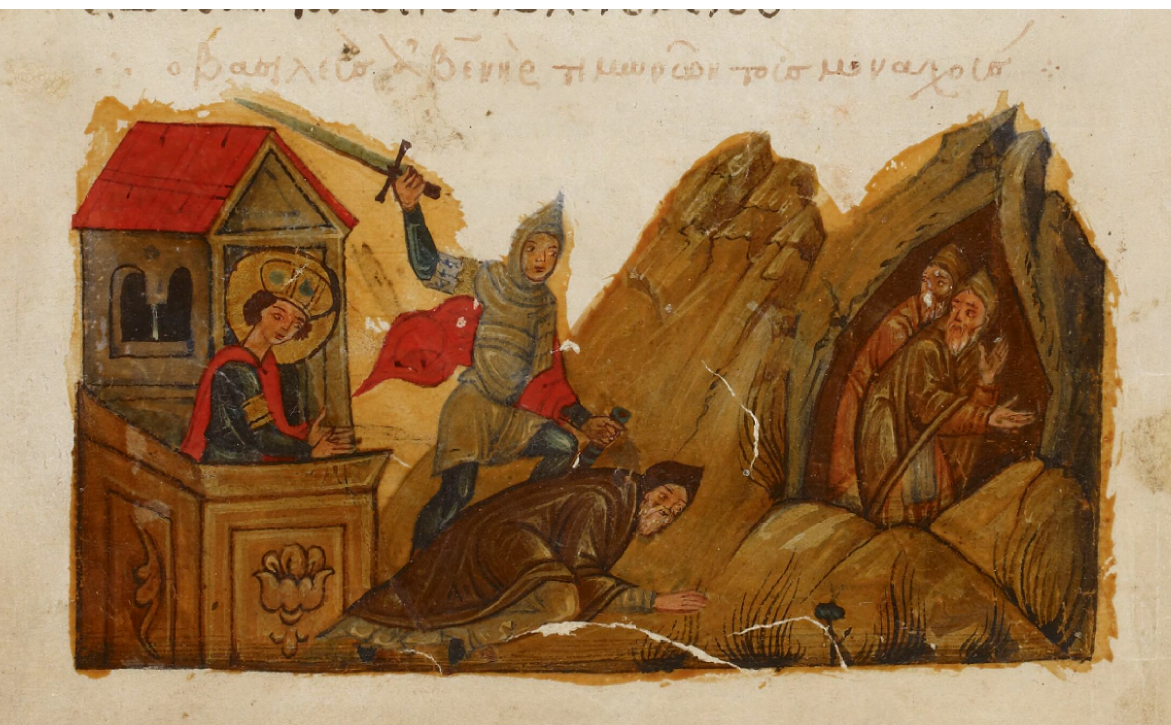
Figure 4. Paris. Biblioth è que nationale de France. Paris. gr. 1128, fol. 4v (detail). King Abenner condemns some monks to death. Photo: gallica.bnf.fr/Biblioth è que nationale de